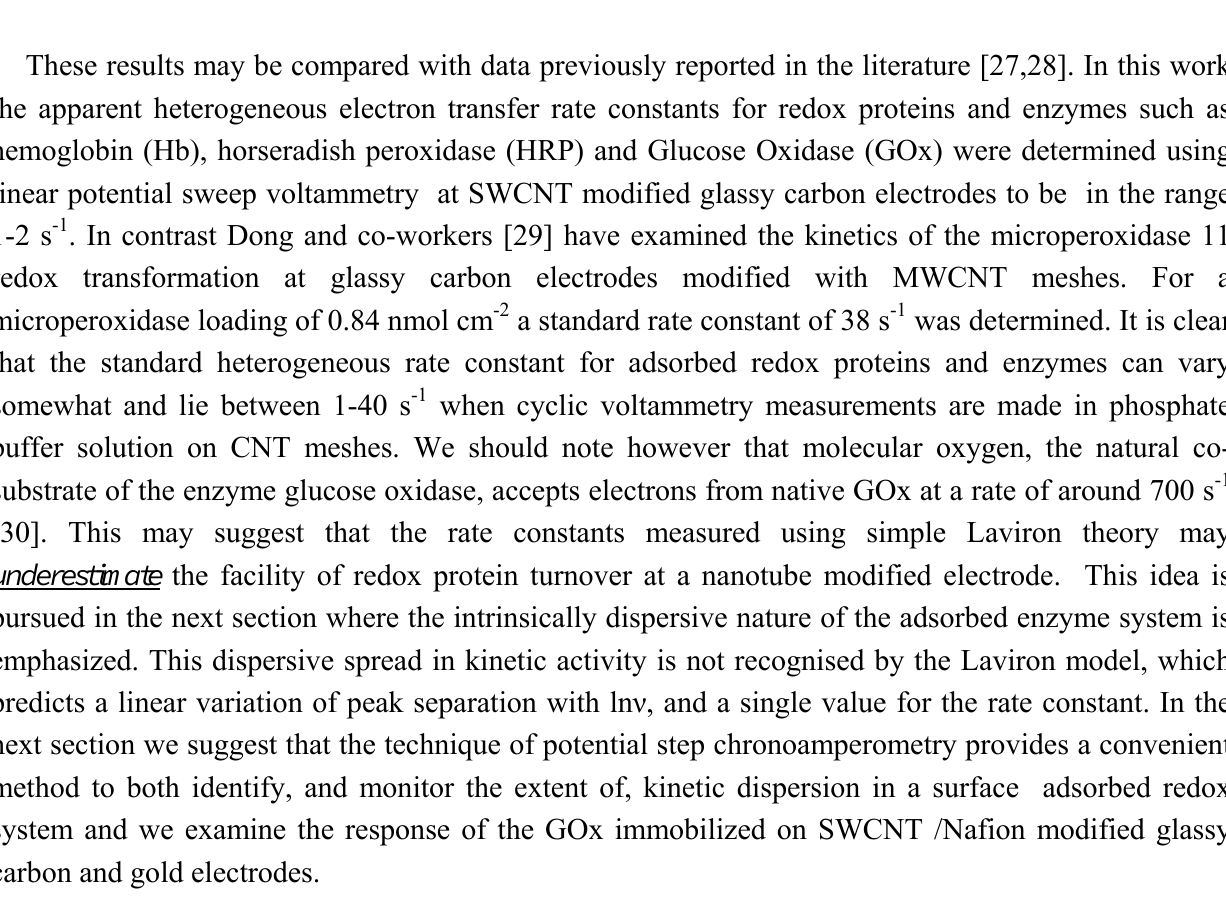
Figure 17. Peak separation against the natural logarithm of scan rate for a SWCNT/GOx/Nafion- modified gold working electrode. The electrolyte used was a 50 mM phosphate buffer (pH